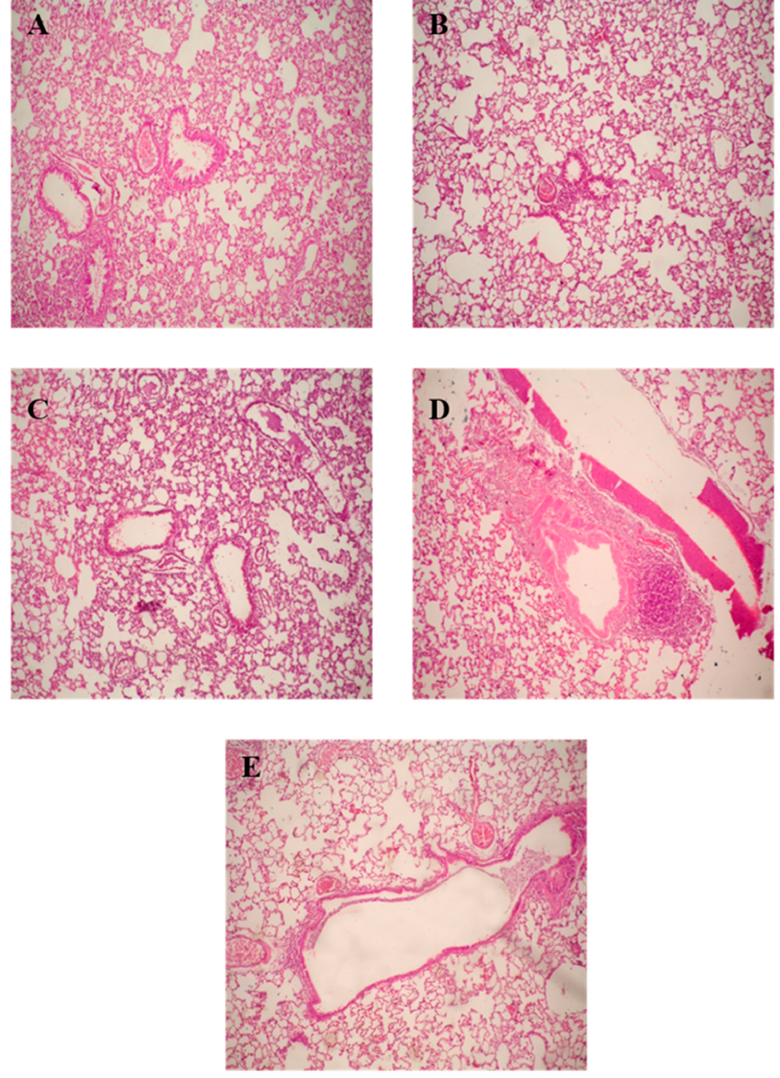
Figure 6. Histopathological photomicrographs of stained lung tissue sections of rats after oro-tracheal administration of different treatments: ( A ) control group, ( B ) P2 TD(3.6) group, ( C ) P2 TD(9) group, ( D ) C4 TD(3.6) group and ( E ) C4 TD(9) group.